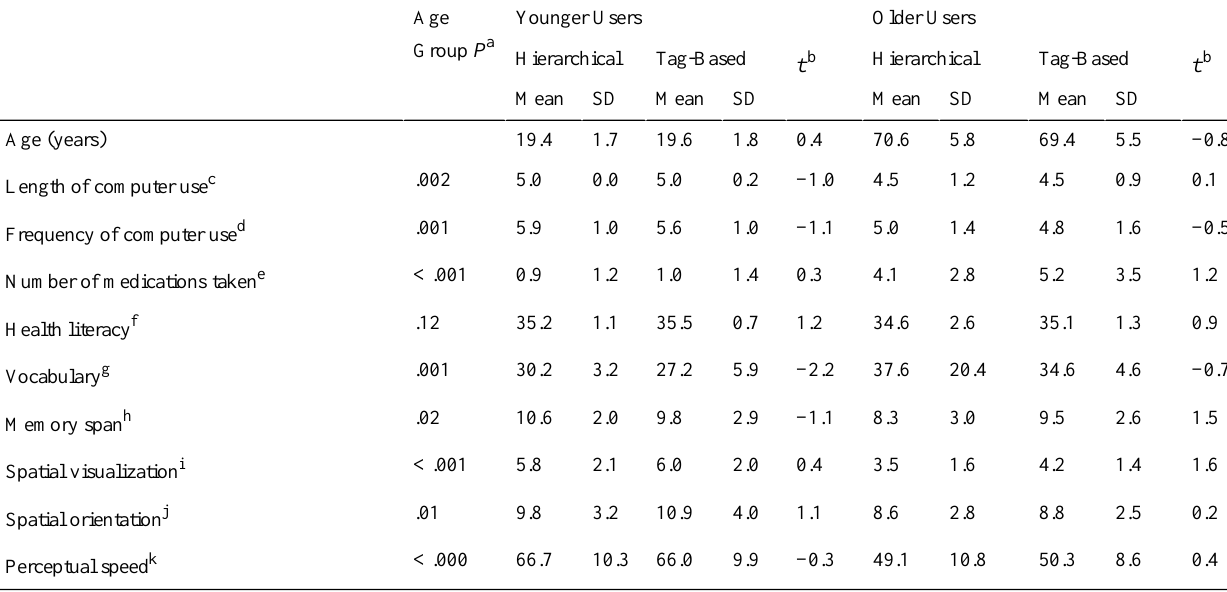
Table 1. Younger and older user characteristics by condition